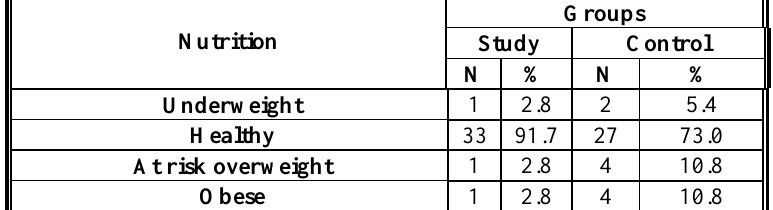
Table 5: The distribution of the study and control group according to nutritional